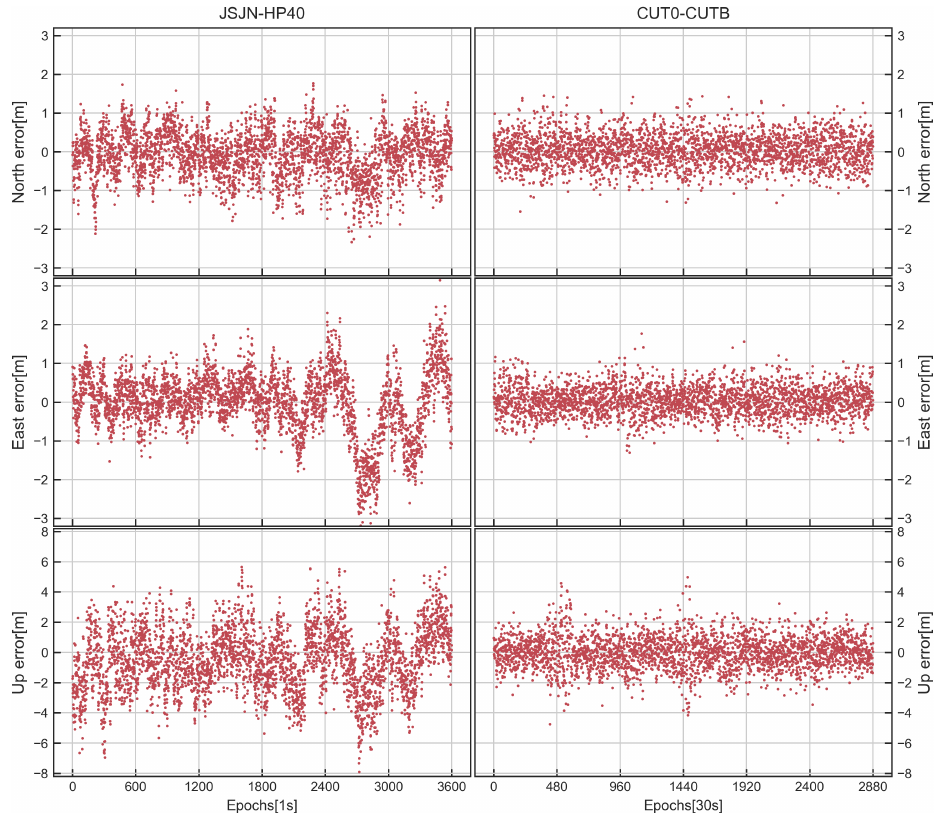
Figure 5. The time series of DD code positioning errors for JSJN − HP40 ( left ) and CUT0 − CUTB ( right